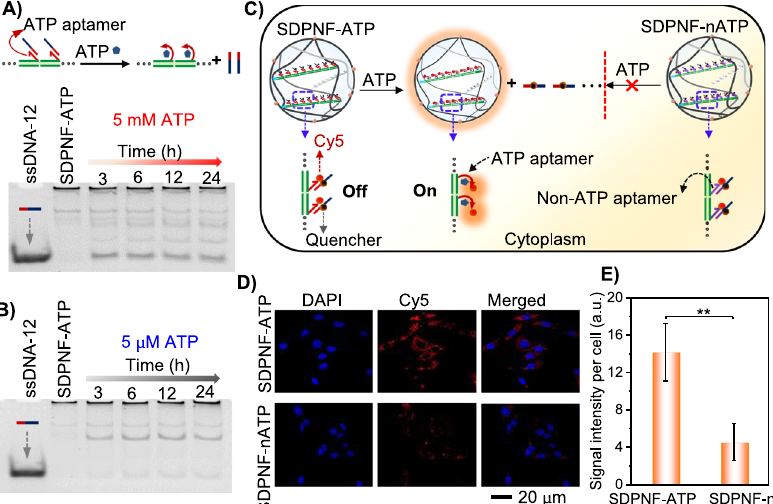
Fig. 5 ATP triggered ssDNA-12 release from ATP-responsive DPNF (SDPNF-ATP). A , B ATP-triggered ssDNA-12 release pro fi les of SDPNF-ATP in which ssDNA-12 was linked via ATP aptamer sequence. The concentrations of SDPNF-ATP and ssDNA-12 were 4.2 mg/ml and 3 μ M, respectively. C Schematic illustration of exploration on ATP-triggered ssDNA-12 release from SDPNF-ATP in cytoplasm via FRET. The 3 ′ overhang of H2 was modi fi ed with Cy5 as a fl uorescent label and the middle base in ssDNA-12 was modi fi ed with BHQ2 as a quencher. SDPNF-nATP, the ssDNA-12 was linked via non- ATP (nATP) aptamer sequence. D CLSM images of MDA-MB-231 cells treated with SDPNF-ATP (420 μ g/ml) and SDPNF-nATP (420 μ g/ml) for 6 h, respectively. E Quantitative analysis of fl uorescence intensity per cell in SDPNF-ATP group and SDPNF-nATP group. Error bars represent s.d. ( n = 20 cells), ** p <